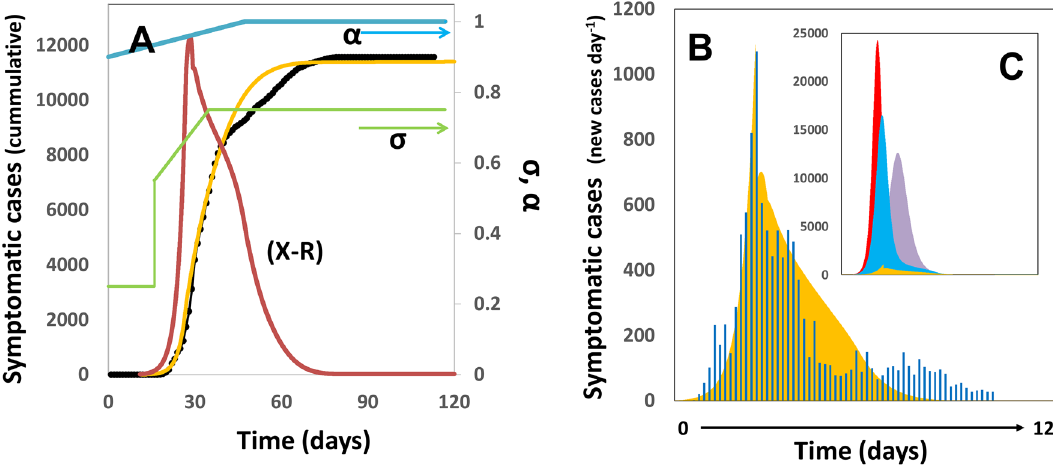
Figure 4. Progression of the COVID-19 Pandemic in South Korea. ( A ) Model prediction of the total number of symptomatic patients through the months of February and May. Actual data points, as officially reported, are shown using black circles. Simulation predictions are described by the yellow line. The profiles of social distancing (σ) and testing effort (α) are shown as green and blue lines, respectively. The value of (X–R), determinant of the progression of the infection among population, is shown as a red line. ( B ) Model prediction (yellow) and actual number of new cases of COVID-19 per day (blue bars; https ://en.wikip